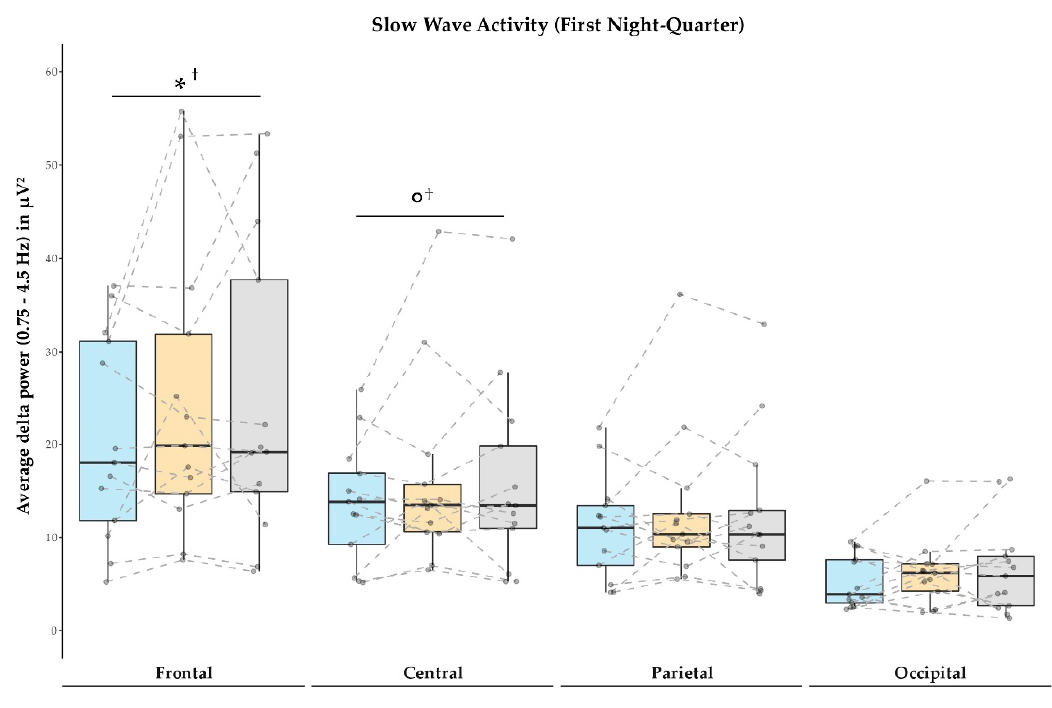
Figure 6. Average SWA (delta power between 0.75 and 4.5 Hz) during N2 and N3 sleep in the first night-quarter across electrode positions and light conditions. SWA was reduced in the “No Filter” compared to the “Book” condition on frontal and central positions. ° = p ≤ 0.10; * = p ≤ 0.05; † = p adj. > 0.10.